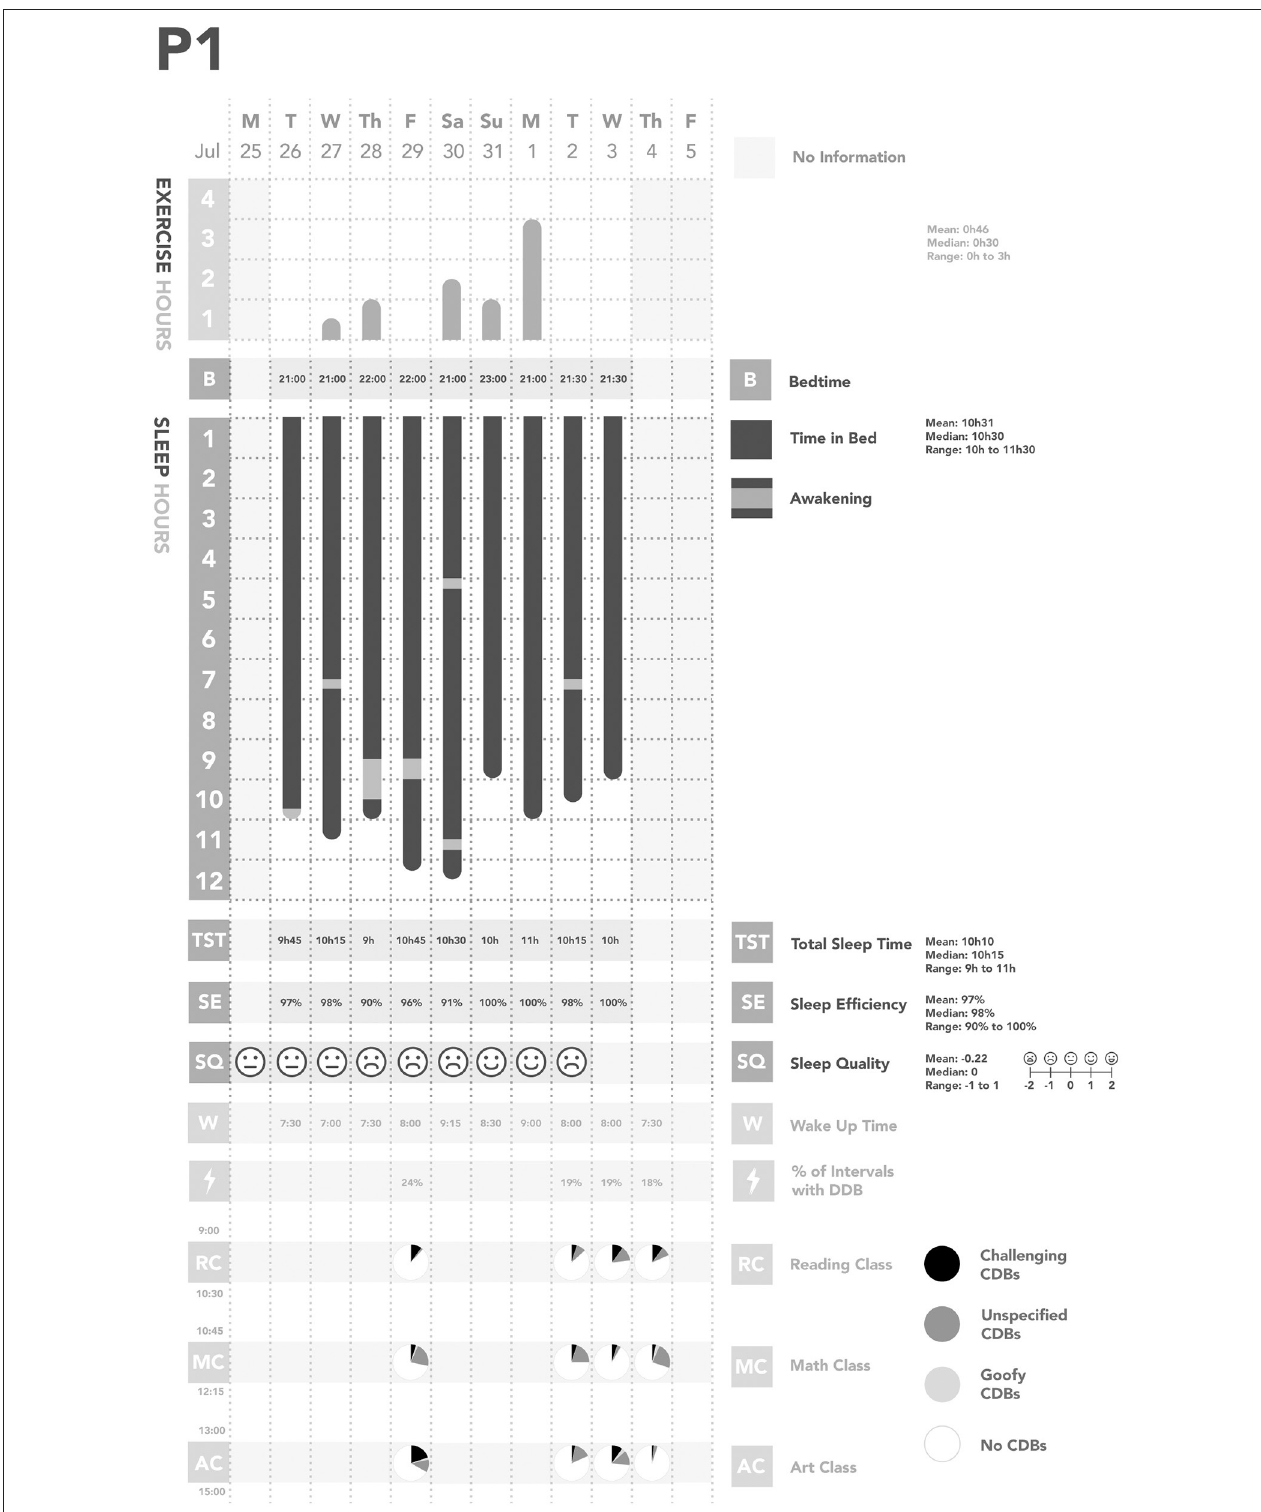
FIGURE 1 | Summary of Participant 1 (P1)’s data. CDBs, Challenging and/or disruptive behaviors.